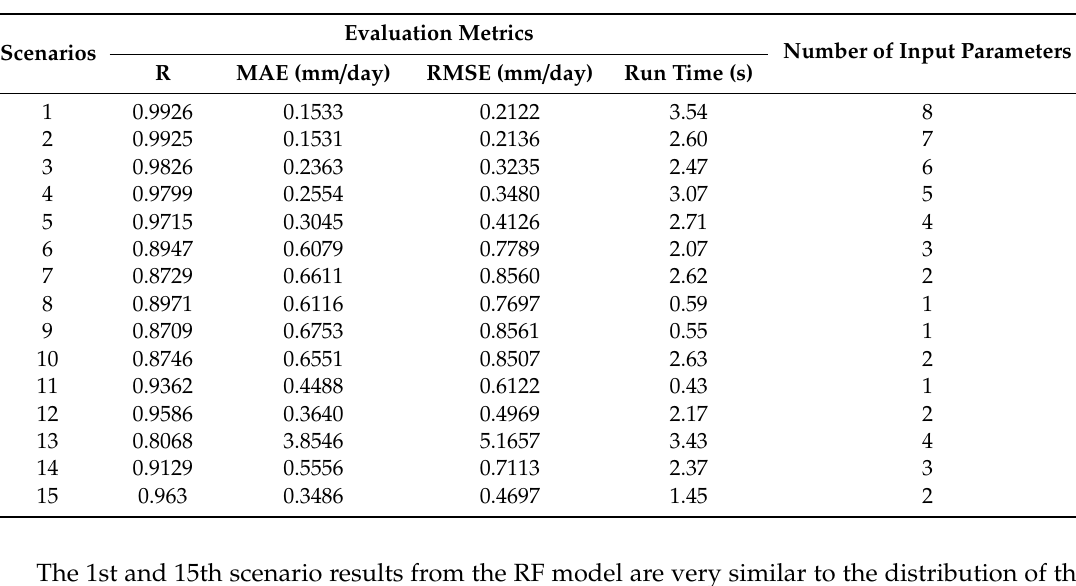
Table 6. RF model results for different scenarios. Scenarios